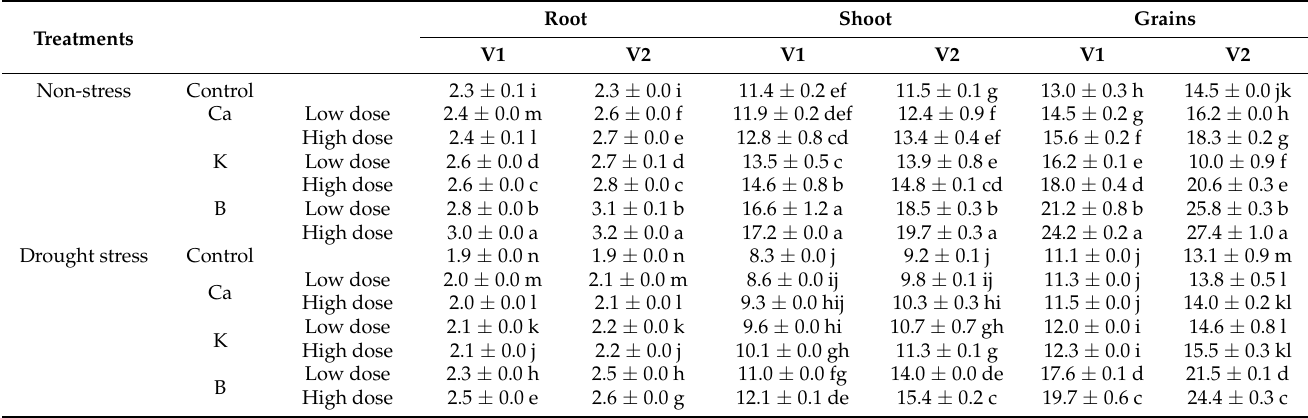
Table 4. Analysis of B content in the root, shoot, and grains of durum wheat. Different letters shows significant difference among the treatments. Standard error was calculated by using the